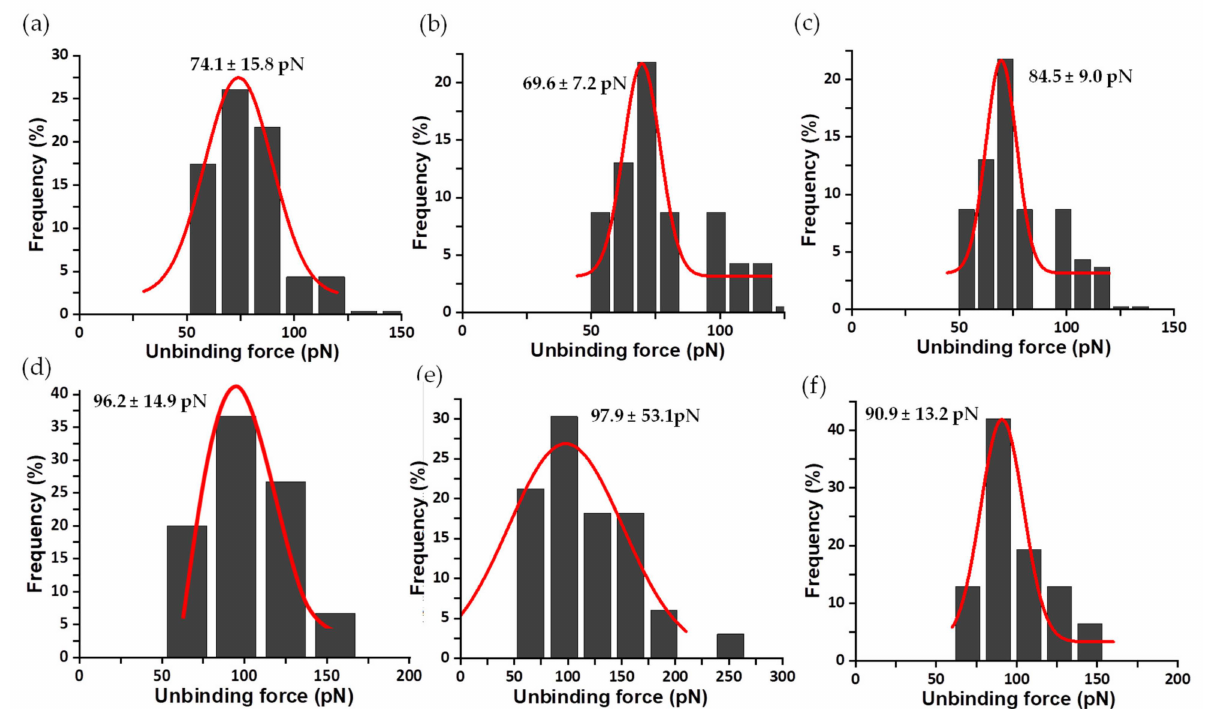
Figure 9. Force histogram distributions for Y303W AnFNR ox :NADP + complexes. Data force obtained operating at R values of 20 ( a ), 31 ( b ), 40 ( c ), 52 ( d ), 58 ( e ), and 75 ( f ) nN/s. The width of the bars varies in each case, depending on the optimum fit with the Gaussian function shown in red. Data from R 10 nN/s were also measured, but are shown below. The fitting provides the most probable unbinding forces corresponding to the rupture of a single complex and is shown on the corresponding graphic.